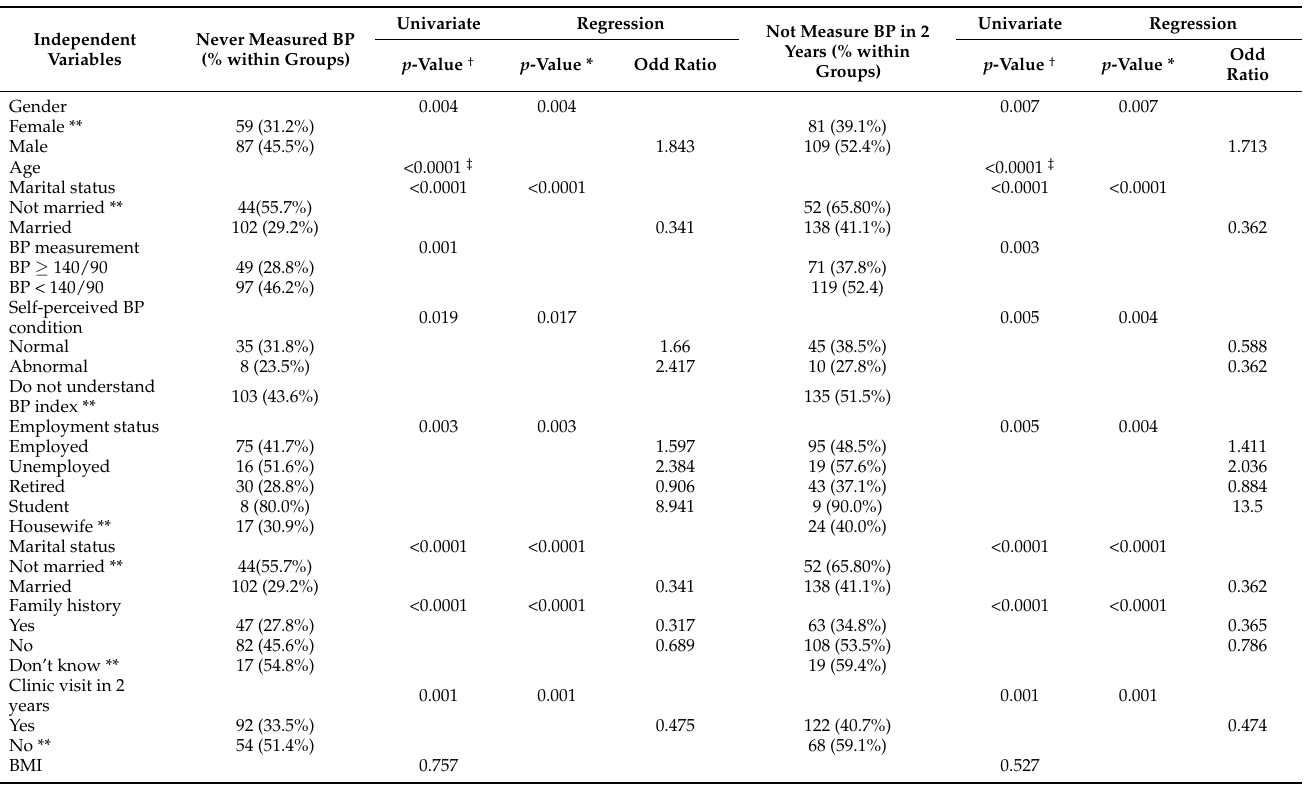
Table 2. Association between clinical/demographic data and not receiving HT screening.